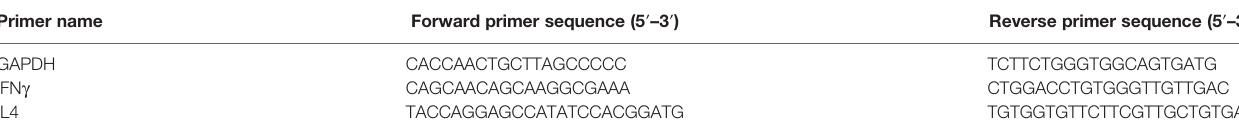
TABLE 1 | Primers used for qPCR